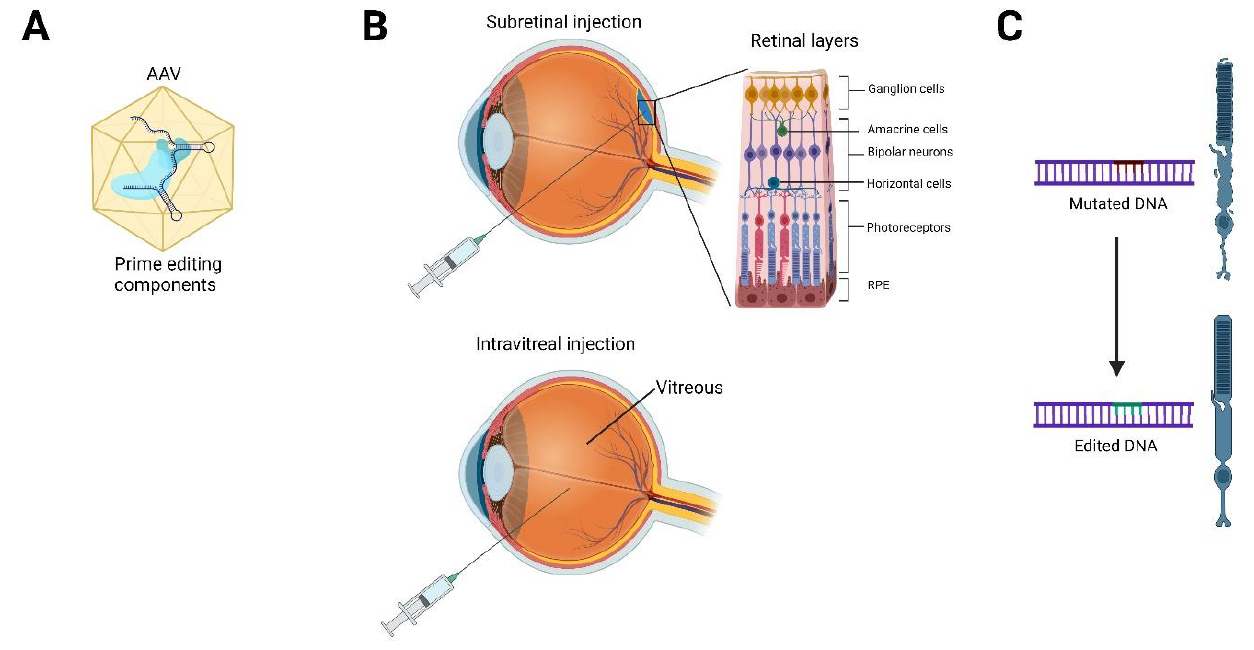
Figure 3. Schematic depicting the gene therapy delivery approach for inherited retinal diseases . ( A )